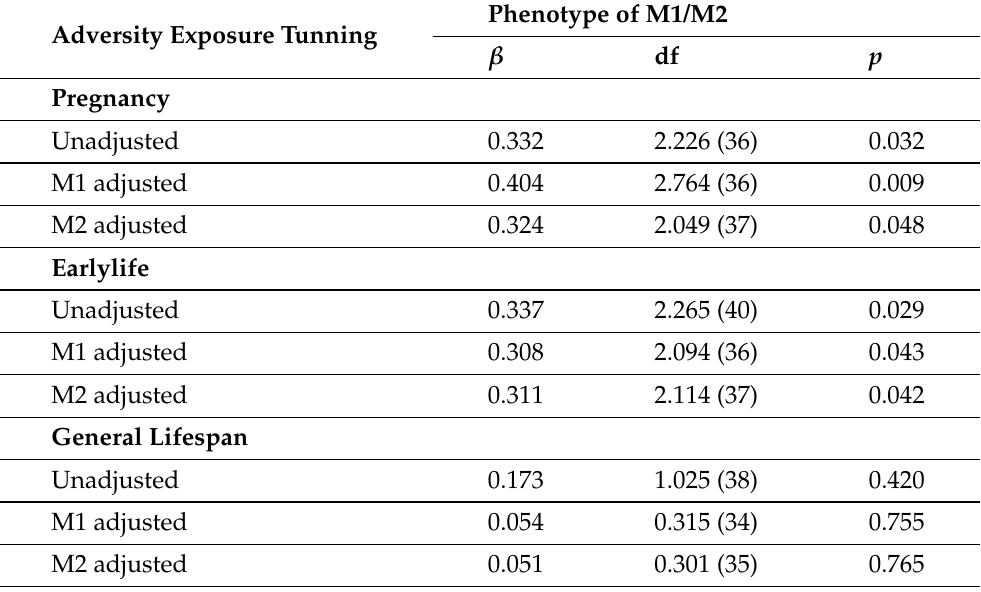
Table 3. One inflammatory marker was chosen as the outcome in each linear regression model, and the chosen life adversity component was chosen as the independent variable. The average blom-standardized scores for IL-1RA, IL-4, IL-10, and IL-1B, IL-6, TNF-a, and CRP are included in the anti-inflammatory and pro-inflammatory aggregates, respectively. Definitions of phenotypes are provided in the procedures. Age, BMI, Hispanic ethnicity, and current antidepressant use were factors in the adjusted model 1; high school education, family poverty, and US birthplace were covariates in the adjusted model 2. Data for three people were lacking when it came to overall life hardship.